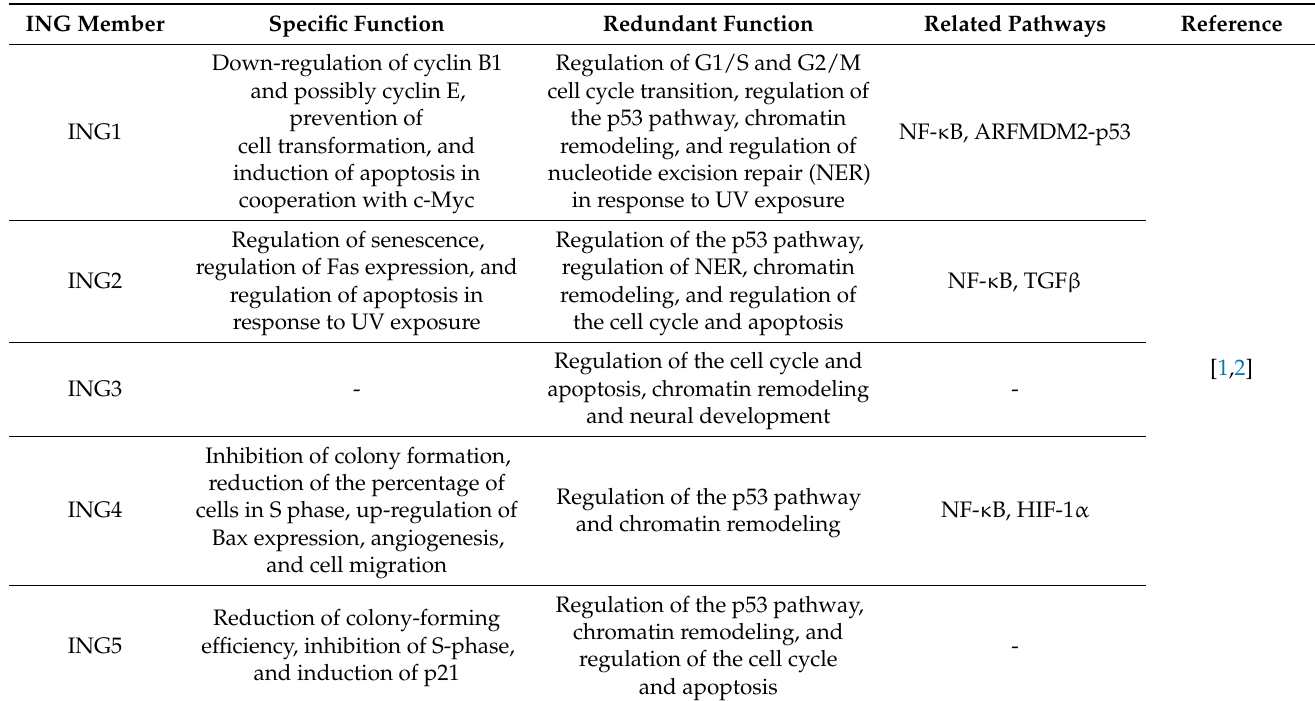
Table 1. Summary of information regarding ING family